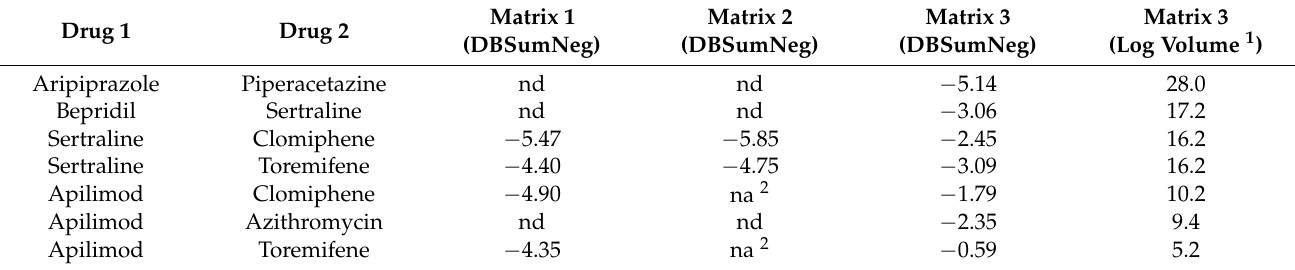
Table 1. Highly synergistic drug pairs from Ref. [22], rank ordered based on Matrix 3, Log Volume scores. Drug